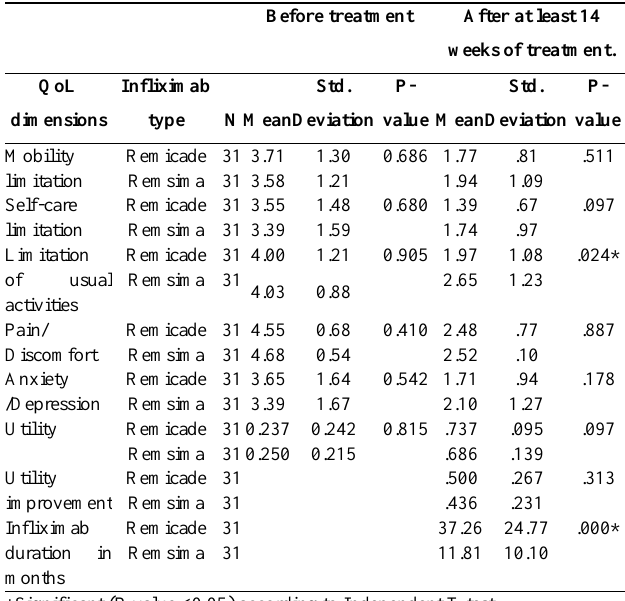
Table 2 : The difference in the quality-of-life dimensions and utility measures between the two groups before and at least 12 weeks after infliximab treatment Before treatment After at least 14 weeks of